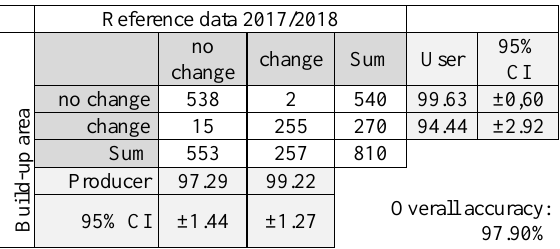
Table 2 . Confusion matrix for change layer Built-up